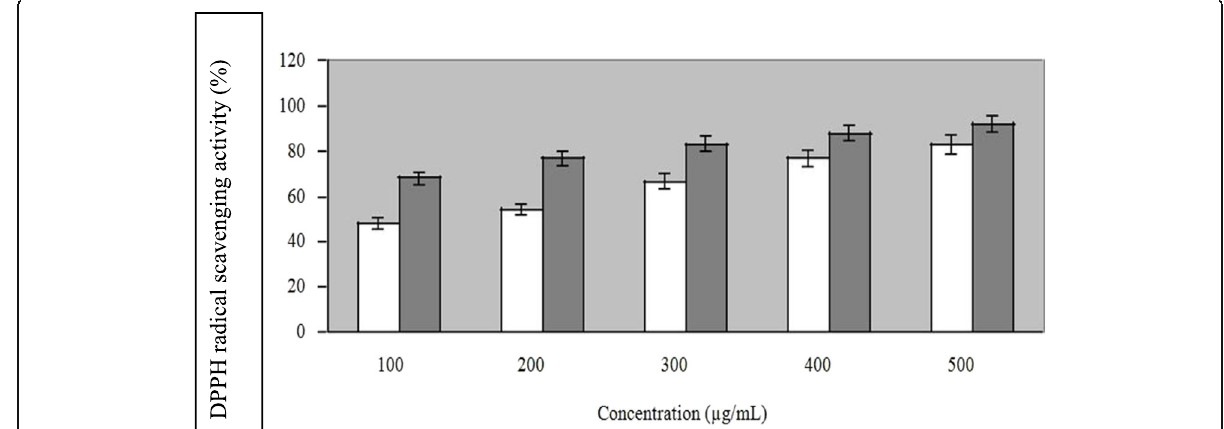
Fig. 4 Scavenging effects of ECP against 1, 1-diphenyl-2-picryl hydrazyl radical with vitamin C used as positive control. Values are means of triplicates ± SD. White bar indicates ECP, Black bar indicates Vitamin C